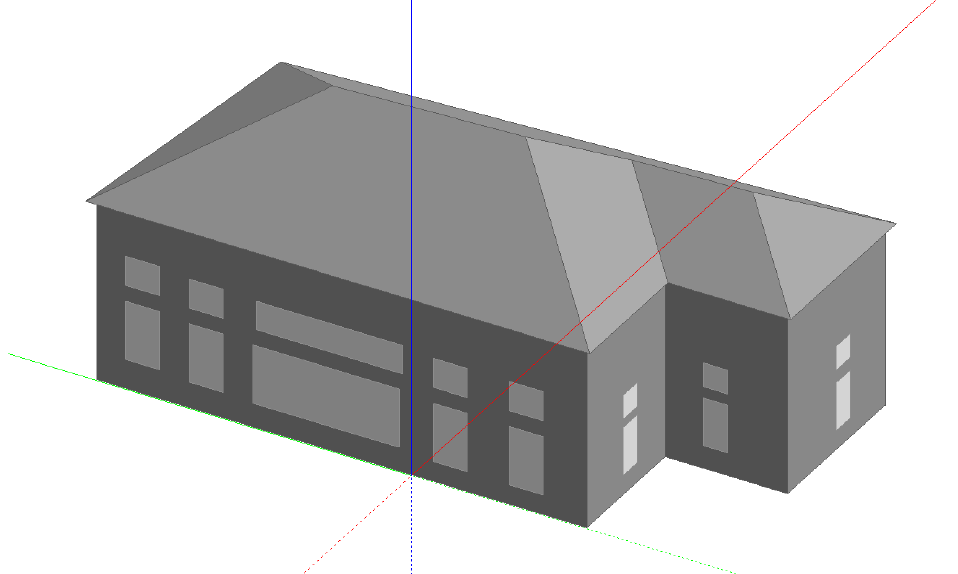
Figure 4. Typical highway service building DesignBuilder model.